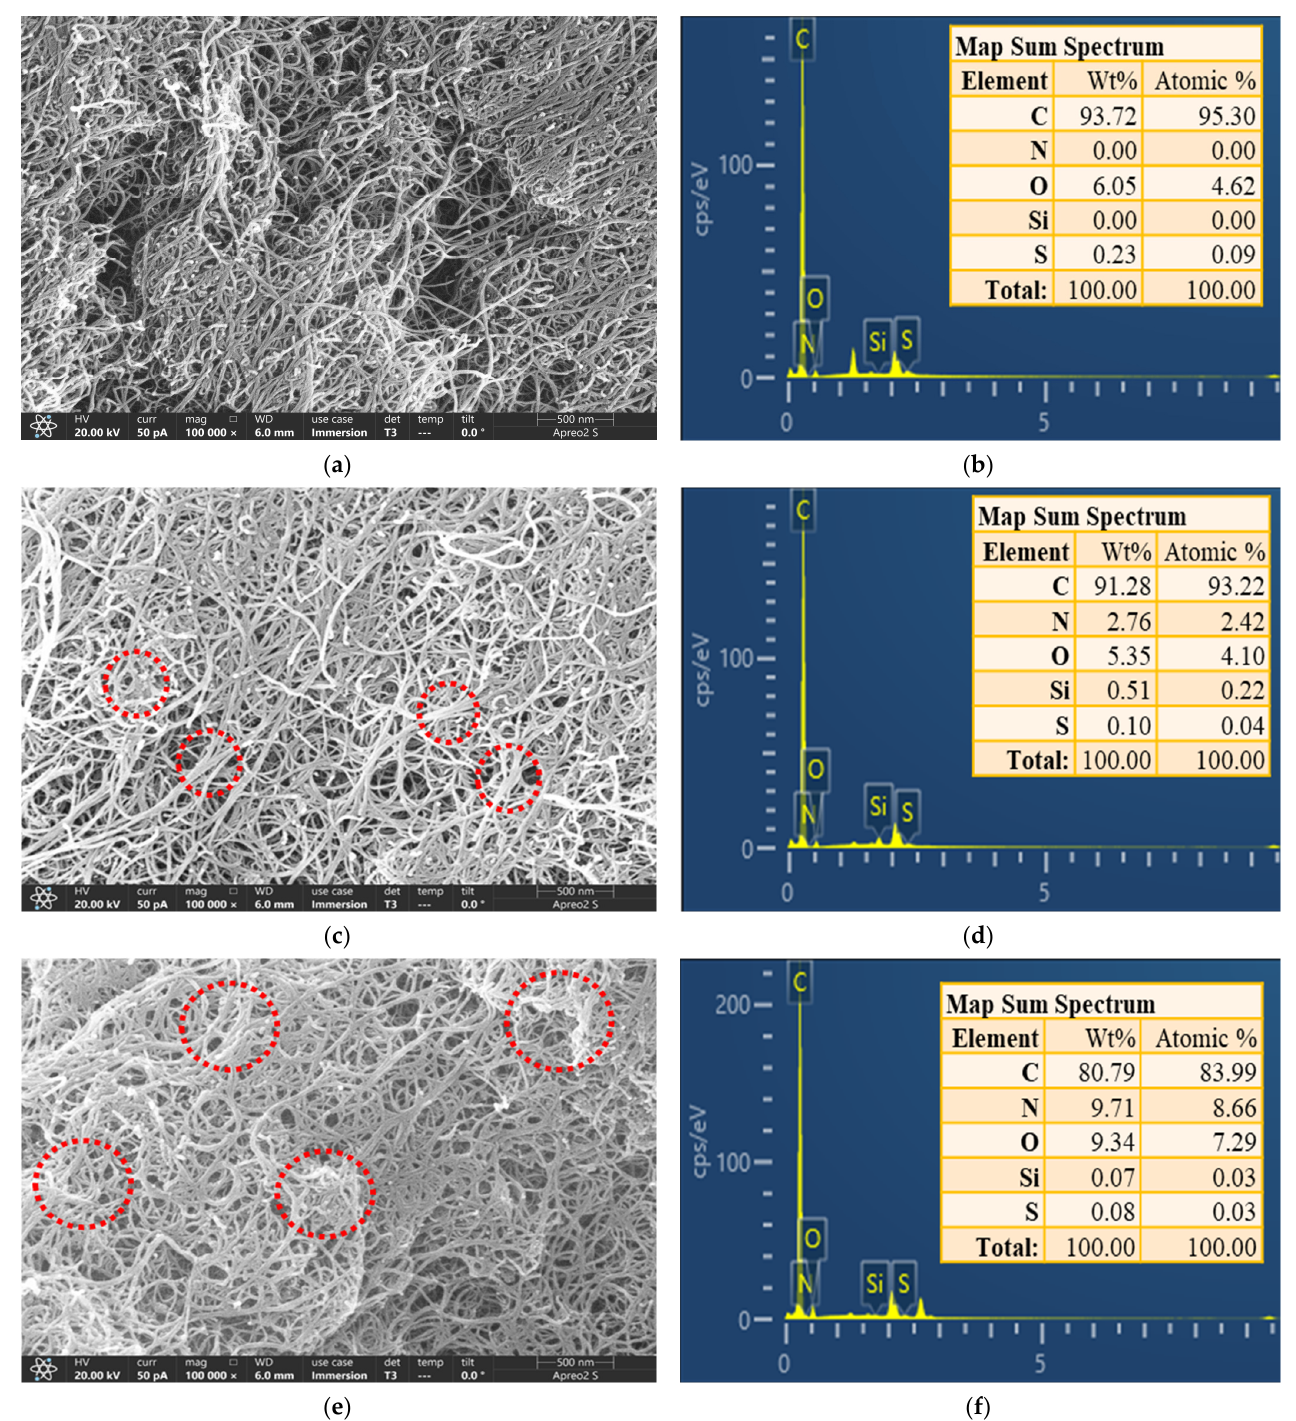
Figure 2. FE-SEM image (magnification ×100,000) and map sum spectrum of ( a , b ) MWCNTs, ( c , d ) APTES-MWCNTs, and ( e , f ) PEI/APTES-MWCNTs. ( c , d ) APTES-MWCNTs, and ( e , f )